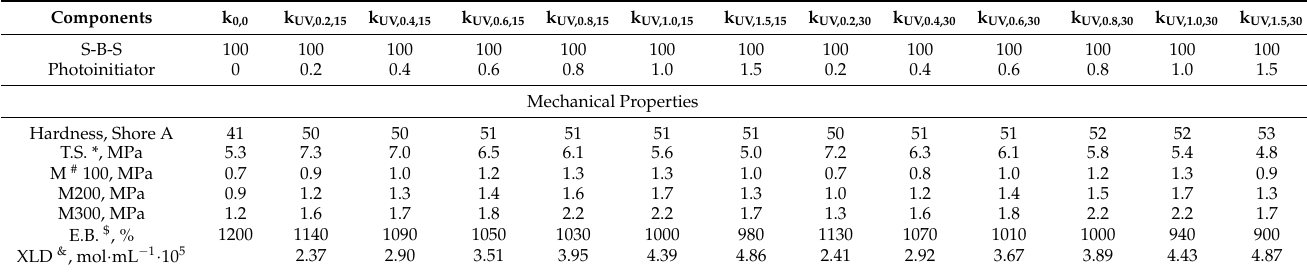
Table 3. Mechanical properties of the compounds at varying times and phoinitiator concentration irradiated with UV of a given frequency and